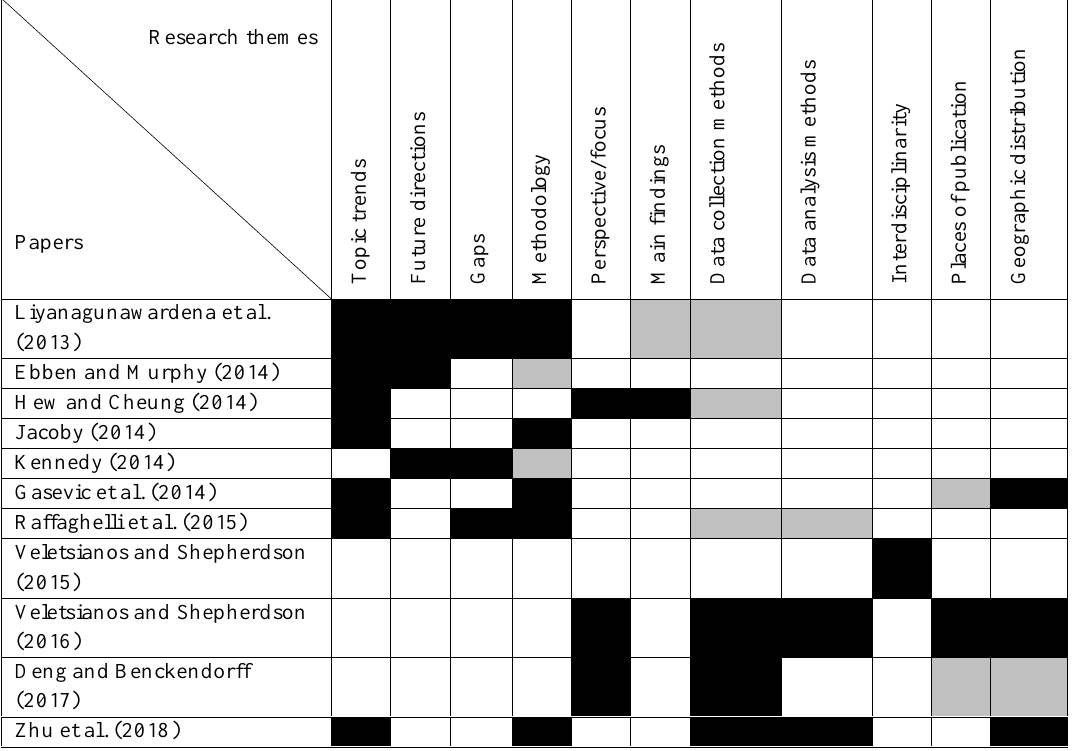
Figure 1. Reviews analyzed and their research objectives. Black indicates that a theme is the article’s main focus and gray indicates a secondary